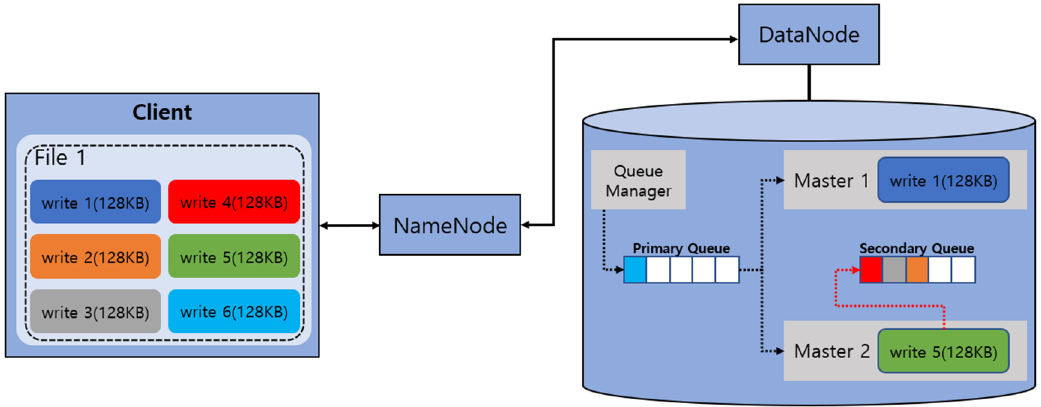
Figure 8. Method in the I/O buffering step.